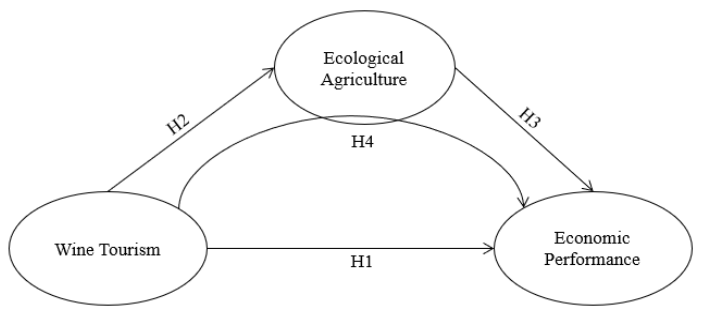
Figure 1. Theoretical model to be tested. Source: Own elaboration.